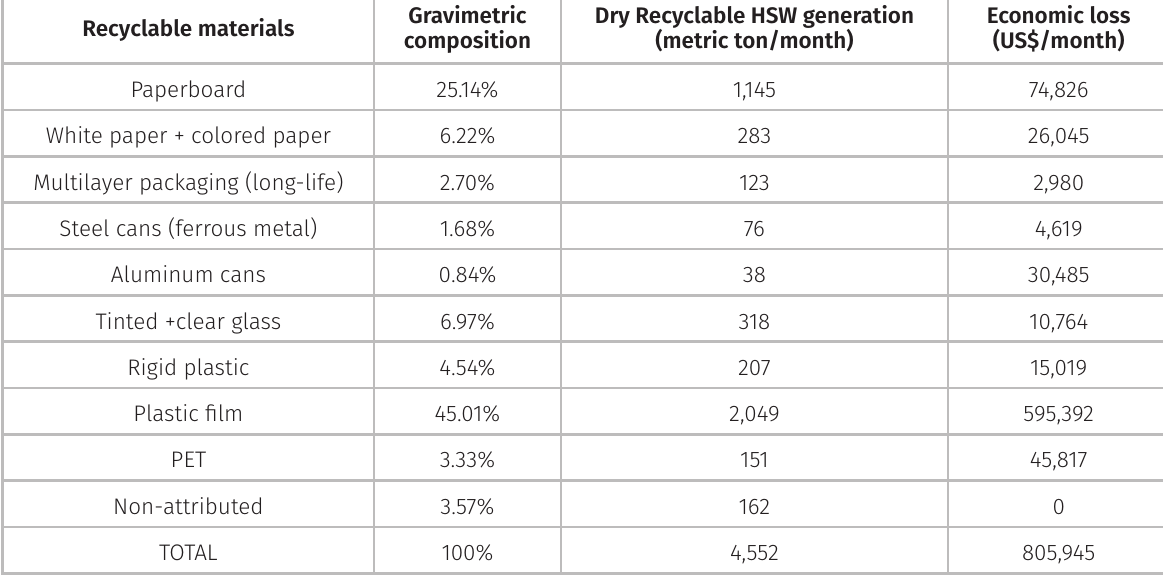
Table III. Economic loss for the non-recycling of dry recyclable household waste for the year